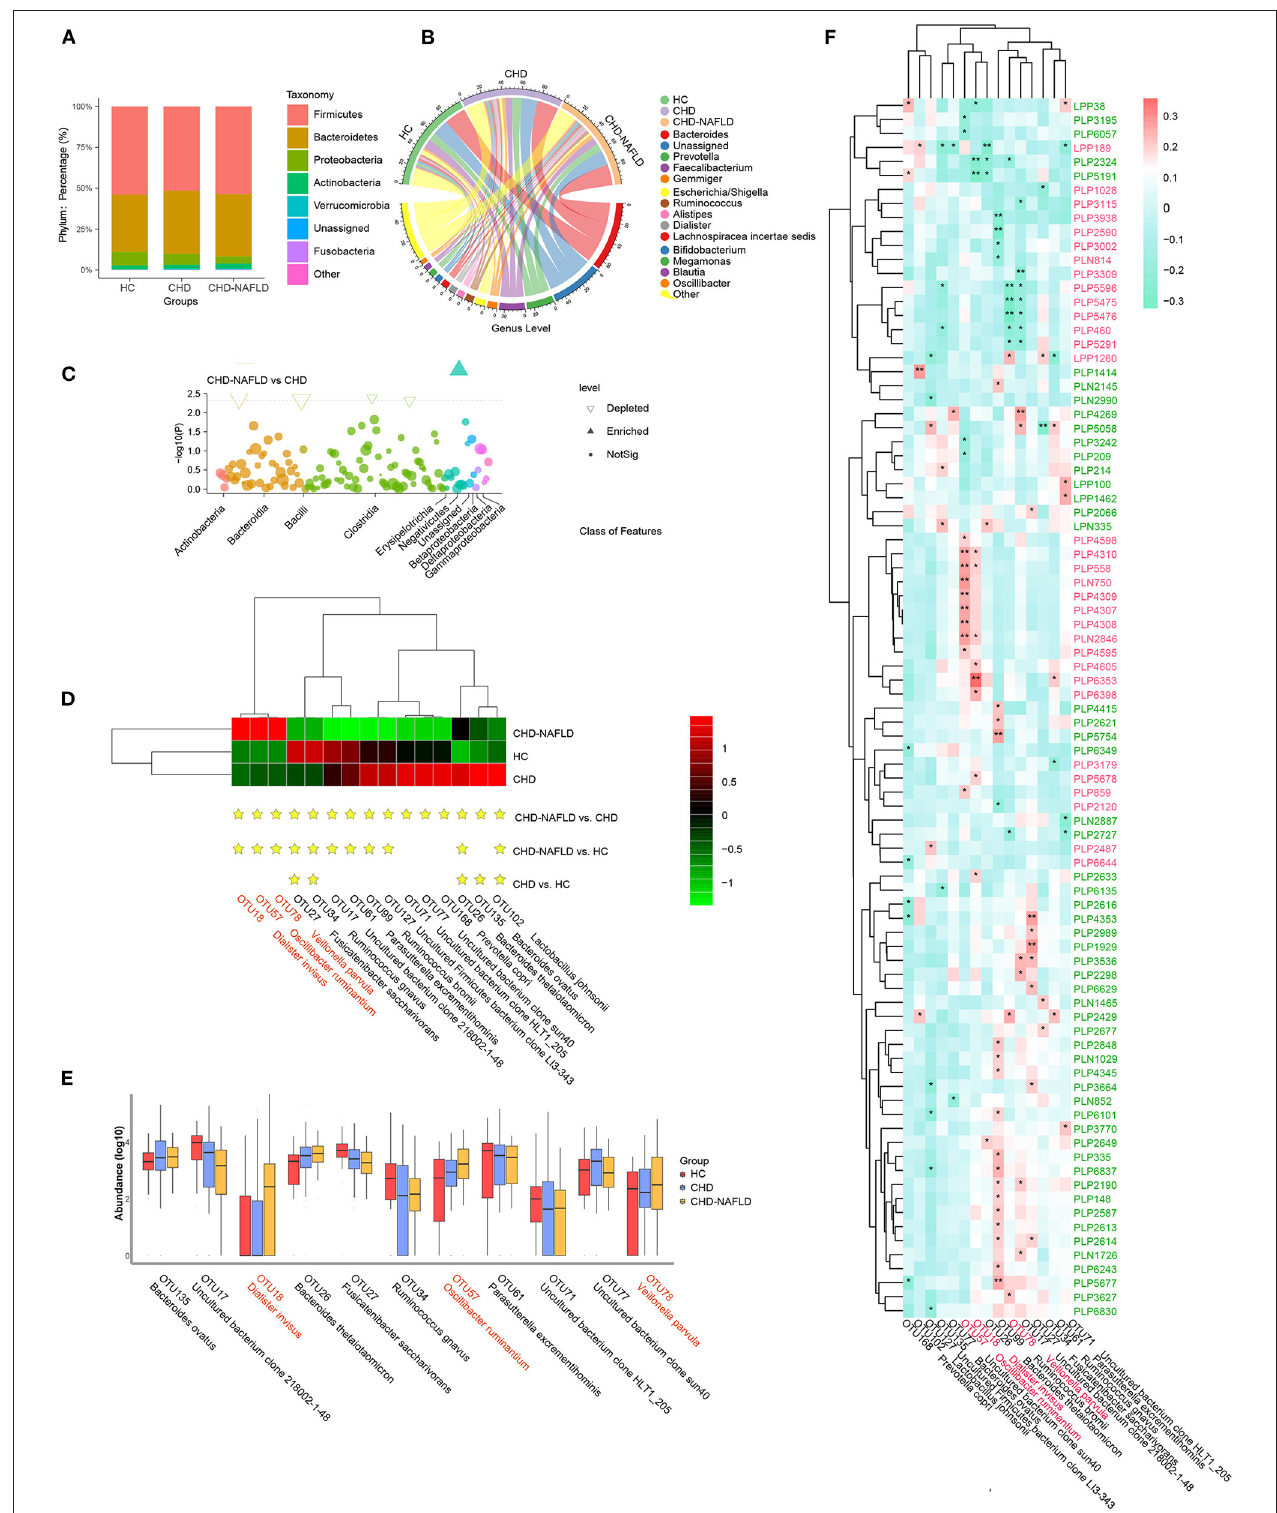
FIGURE 2 | Distinct gut microbiome in different groups. (A,B) Phylum-level and genus-level composition of gut microbiome in patients with CHD-NAFLD, patients with CHD, and healthy controls (HC). (C) Differential bacteria at class-level between CHD-NAFLD group and CHD group. (D) Species-level alterations in